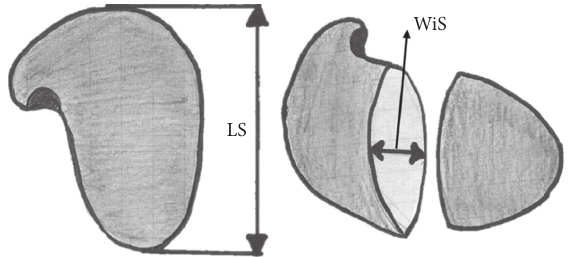
Figure 6: P. erinaceus seeds’ measurements (drawing: Johnson B. N.). Table 5: Mean values and coefficients of variation (CV in percentage) of dendrometric